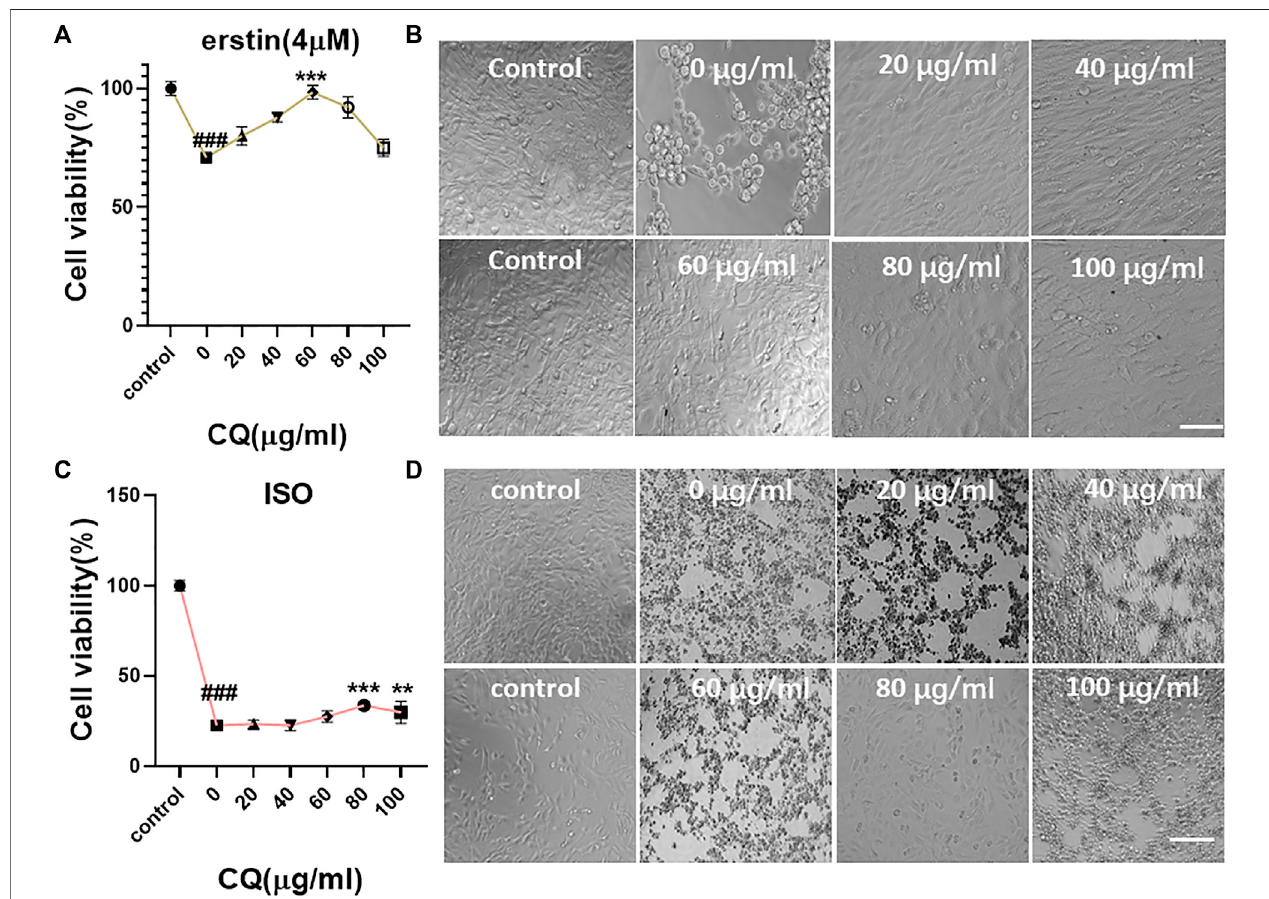
FIGURE 6 | Blocking effect of CQ on ferroptosis in mouse cardiomyocytes. (A,B) The medium containing 4 μ M erastin and different concentrations of CQ (control group withouterastinandCQ)werecoincubatedwithHL-1cellsfor24h.Theviabilityofcellswasdetectedusing theCCK-8reagent,andthesurvivalstatus ofcellswas observed under amicroscope. When the concentration ofCQ was 0 μ g/ml, the cell viability was70.79% ± 1.91%. When the concentration of CQ was60 μ g/ml, the cell viability was 98.42% ± 2.65% (vs. control group, ### p < 0.001, vs. “ 0-µM group, ” *** p < 0.001, n = 5, Bar = 50 µm). (C,D) The medium containing 2-mM ISO and differentconcentrationsofCQ(controlgroupwithoutISOandCQ)werecoincubatedwithHL-1cellsfor24h.TheviabilityofcellswasdetectedusingtheCCK-8reagent, and the survival status of cells was observed under a microscope. When the concentration of CQ was 0 μ g/ml, the cell viability was 22.52% ± 1.18%. When the concentration of CQ was 80 μ g/ml, the cell viability was 33.56% ± 1.84% (vs. control group, ### p < 0.001, vs. “ 0-µM group, ” *** p < 0.001, n = 5, Bar = 50 µm).